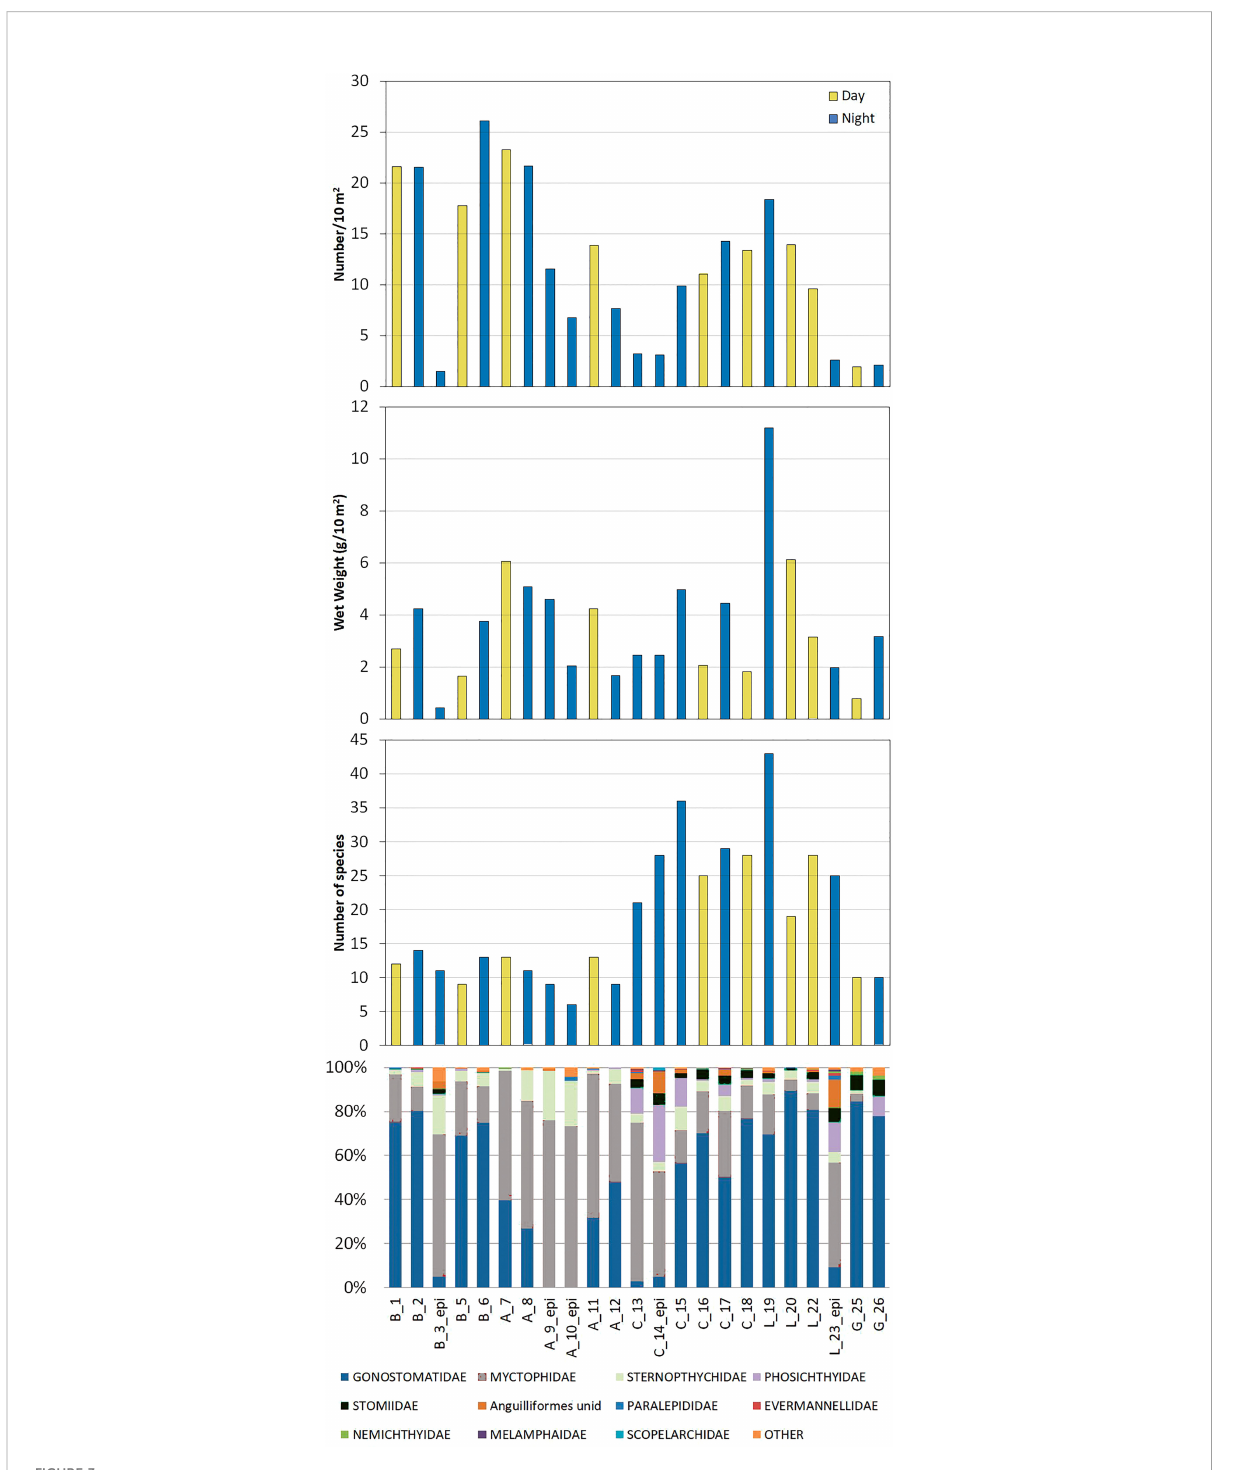
FIGURE 3 Abundance (number/10 m 2 ), biomass (wet weight g/10 m 2 ), number of taxa and relative contribution of different families in the different sampled stations from 0-700 m, or from 0-210 m in case of epipelagic night stations (epi). The fi rst letter of each station label indicates the zone of study (B: Balears, A: Alboran, C: Cadiz, L: Lisboa and G: Galicia), followed by station number and the light condition (D: day and N: